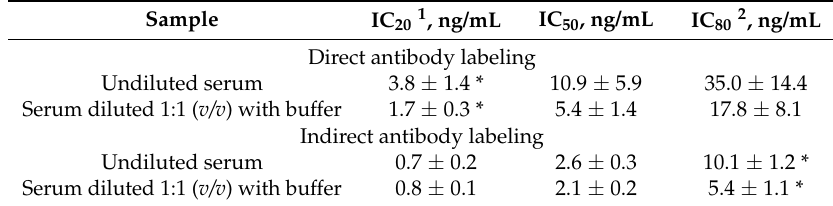
Table 1. Analytical parameters of two tetracycline ICA schemes ( n = 3).